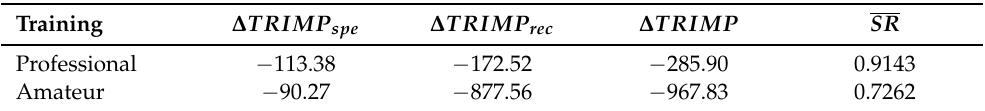
Table 7. Final results of both